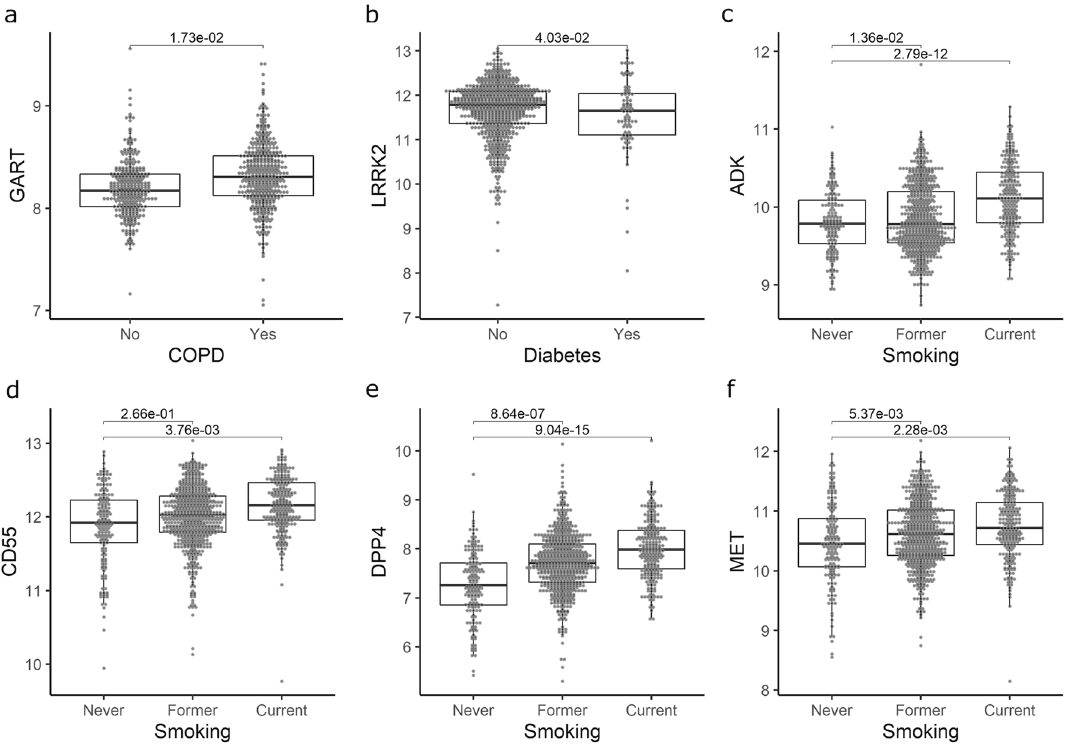
Figure 3. Effects of COVID-19 risk factors on lung tissue gene expression. y axes represent the microarray gene expression level in lung tissue for ACE2 -correlated genes ( GART [ a ] , ADK [ c ], DPP4 [ e ]) and TMPRSS2 - correlated genes ( LRRK2 [ b ] ,CD55 [ d ], MET [ f ]). Boxes are median expression ± interquartile range respectively. Numbers at the top of each box plot are FDR obtained from the robust linear regressions. Figure was created using R 3.6 (https ://www.r-proje ct.org/) 11